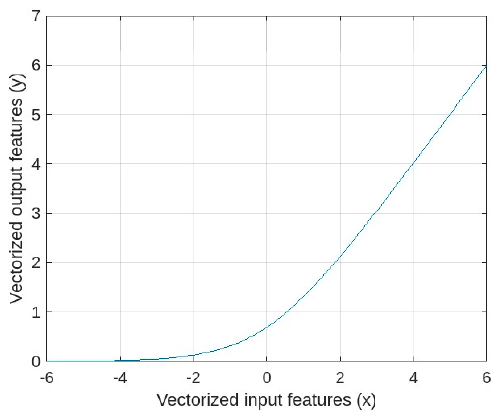
Figure 1. Softplus activation function.